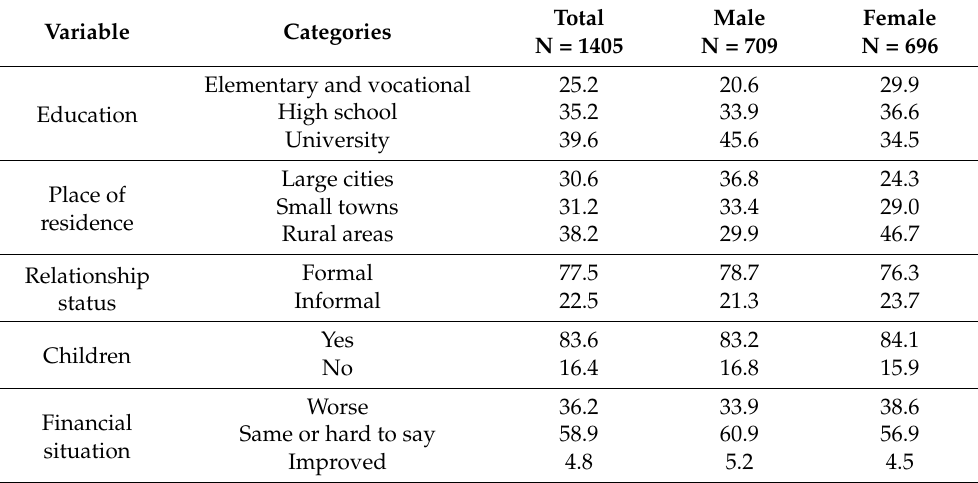
Table 1. Sample characteristics: individuals in relationships (all data presented as